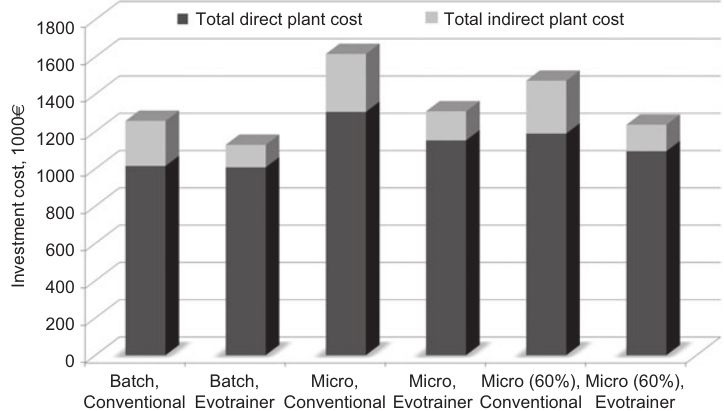
Figure 3 Fixed capital investment estimated for the six cases considered (all 200 t/a; fine-chemical